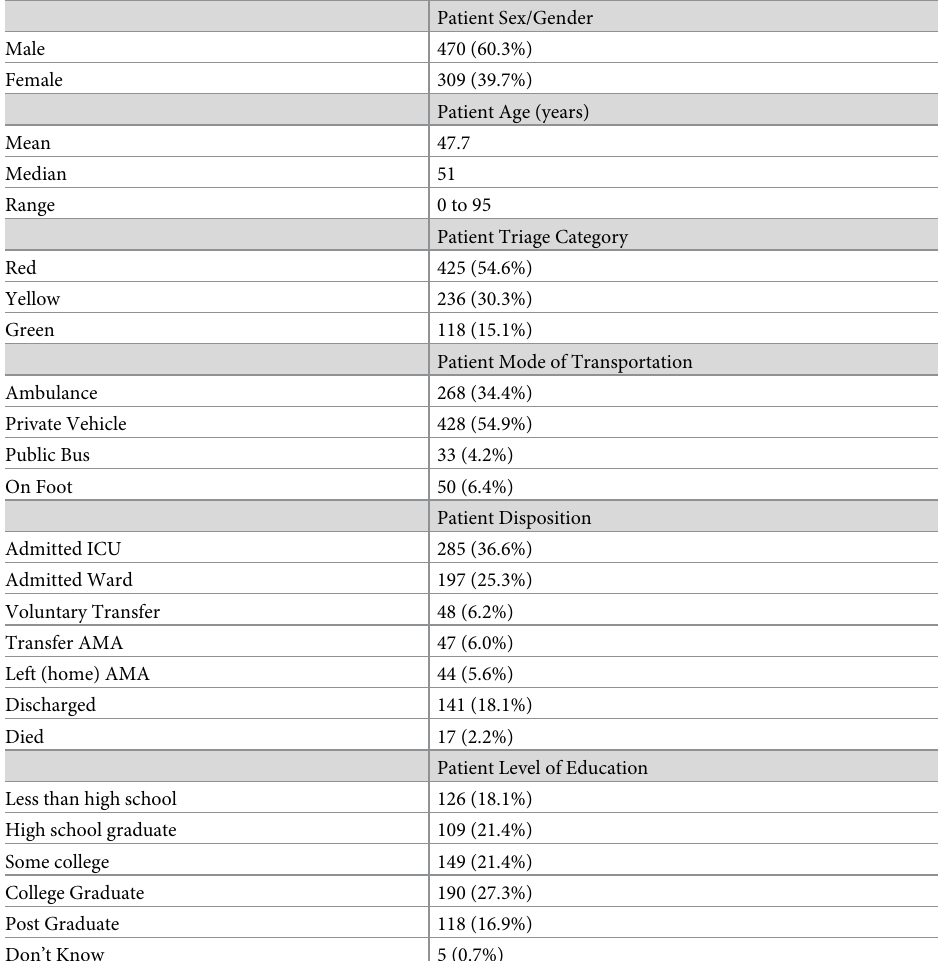
Table 2. Patient demographics.